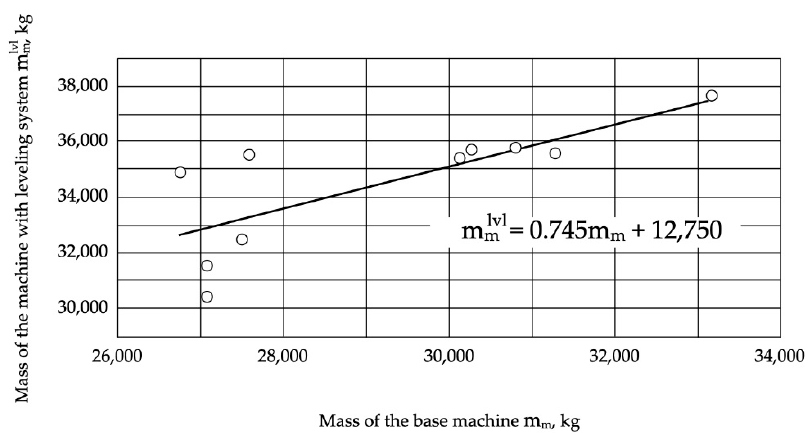
Figure 7. Changing the mass of the base machine when adding a leveling system to the design.